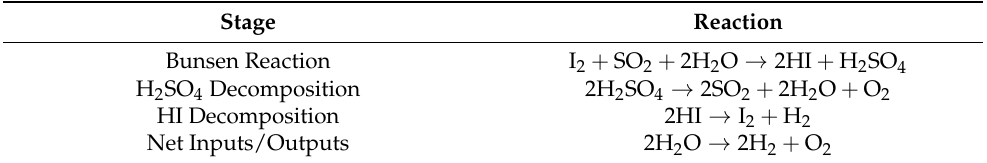
Table 1. IS cycle